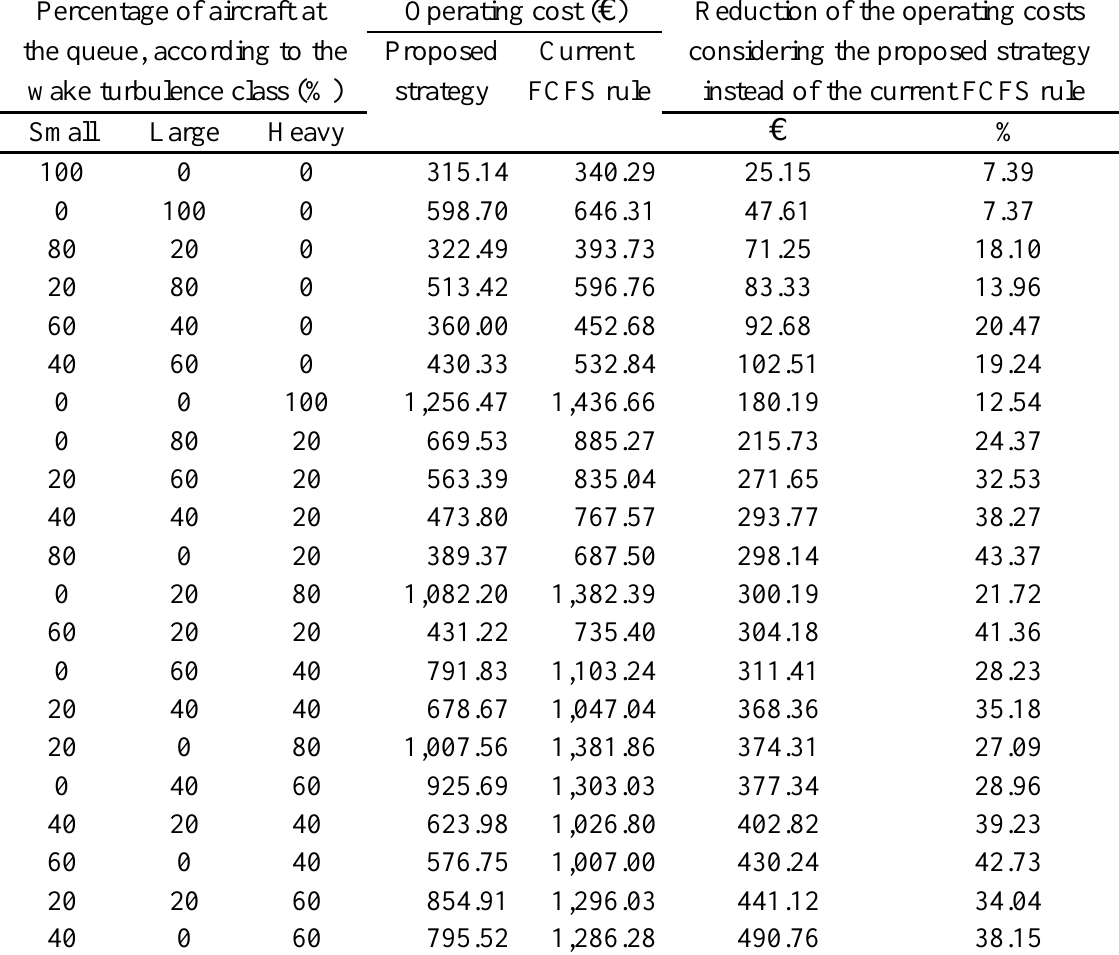
Table 2. Operating costs obtained for a queue of five aircraft considering the current FCFS rule and the strategy proposed